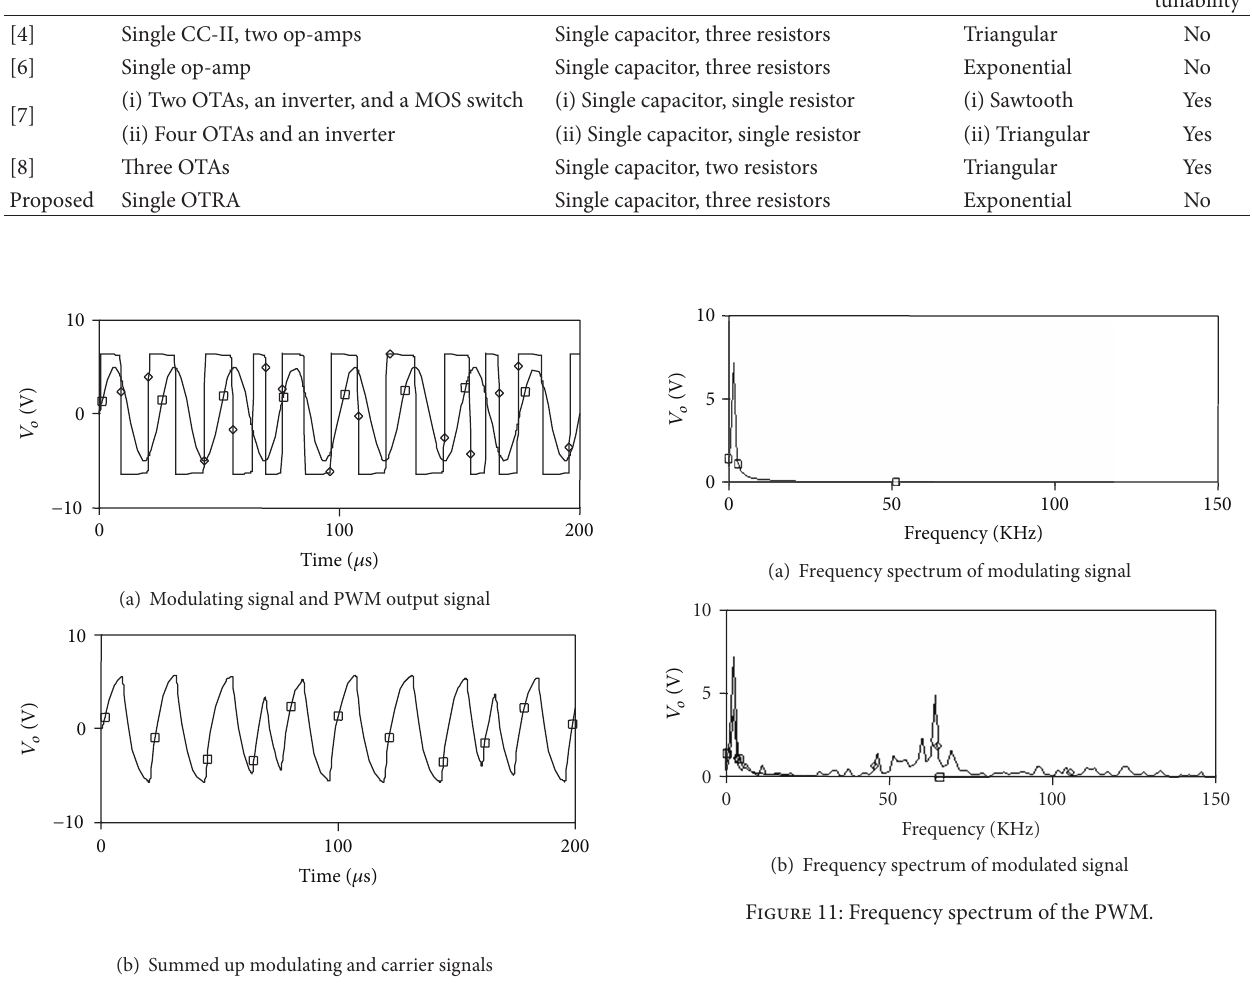
F 10: PWM output for 5V, 40KHz modulating signal.